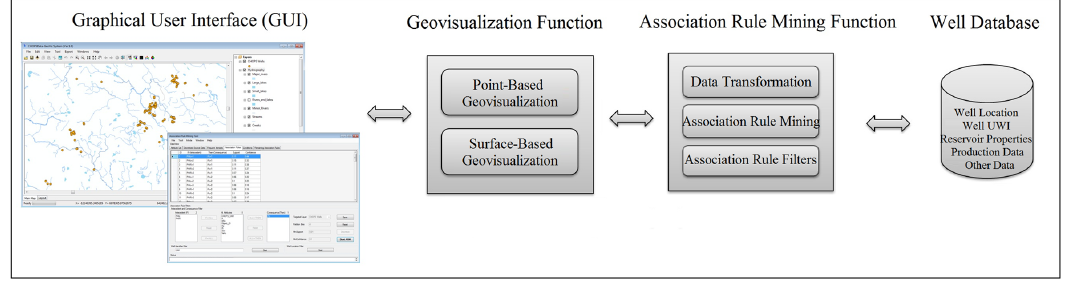
Figure 3. Architecture of the ARM-GEOVIZ prototype.